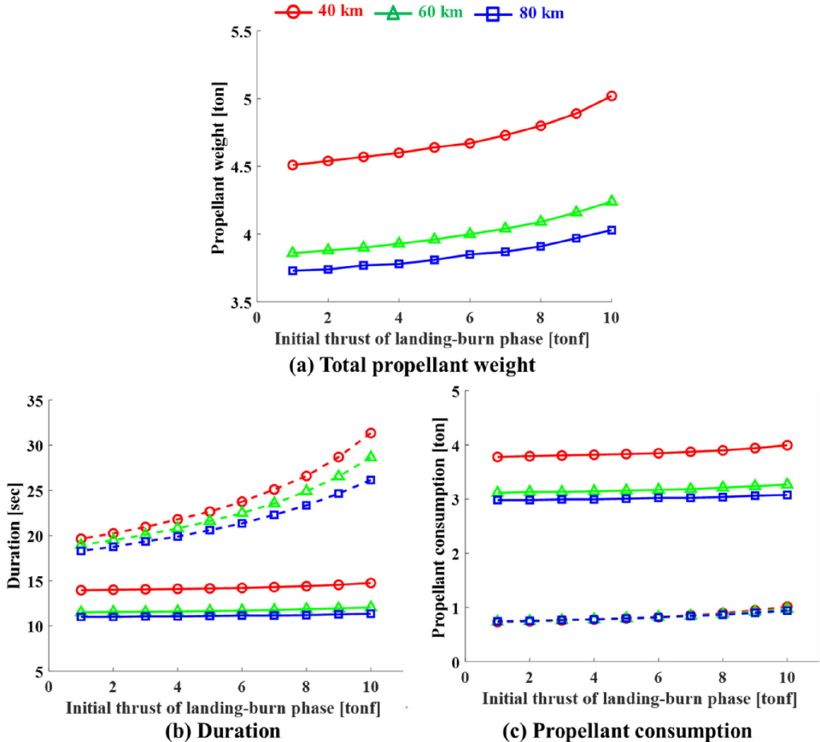
Figure 19. Required propellant weight according to the landing-burn starting thrust. ( a ) Total propellant weight; ( b ) Duration; ( c ) Propellant consumption.